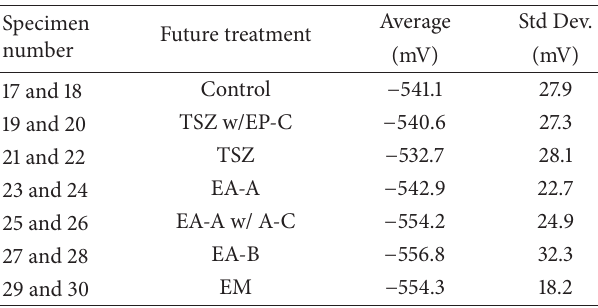
Table 8: Half-cell potential readings after 3 months.